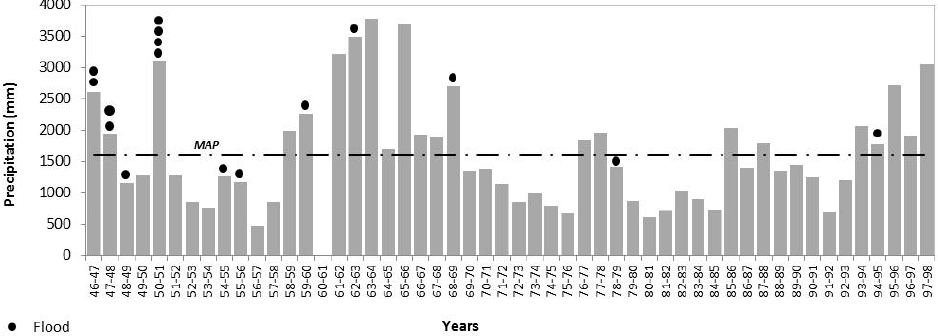
Figure 3. Annual precipitation (hydrological year) and flood events (Meteorological station: Lamas de Olo). Black line symbolizes mean annual precipitation (MAP) and dots indicate flood events. However, the occurrence of flooding can be associated to intense precipitation periods concentrated in just a few days, independently of the previously accumulated precipitation. On 16 February 1963, 291 mm of precipitation were recorded in two days, with an estimated return period of 105 days.